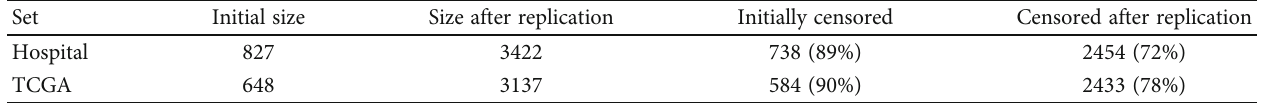
Table 15: Joint states before and after replication.